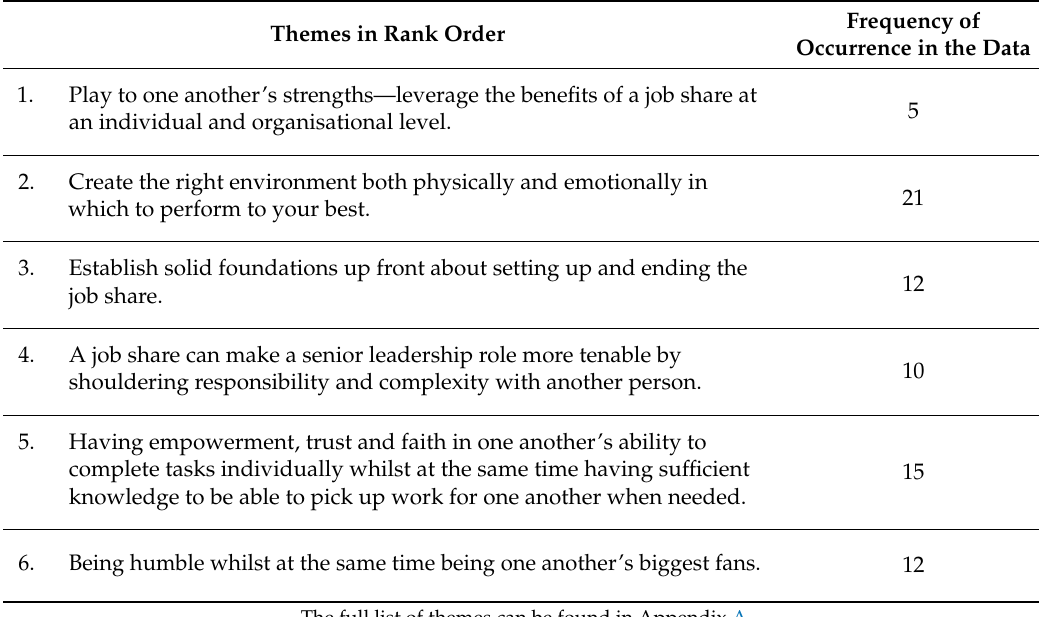
Table 1. Analysed theme titles and rank